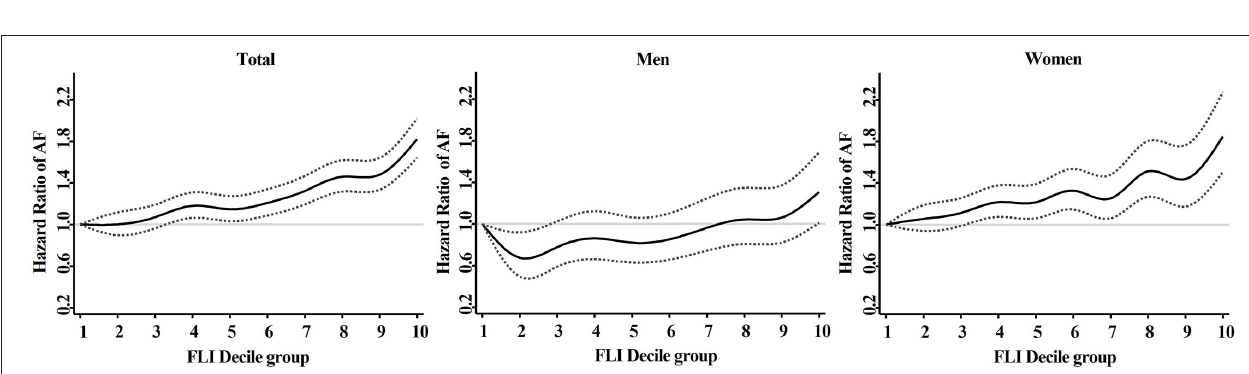
CI 1.16 to 1.30, FLI ≥ 60 group: HR 1.56, 95% CI 1.45 1.66) ( Table 2